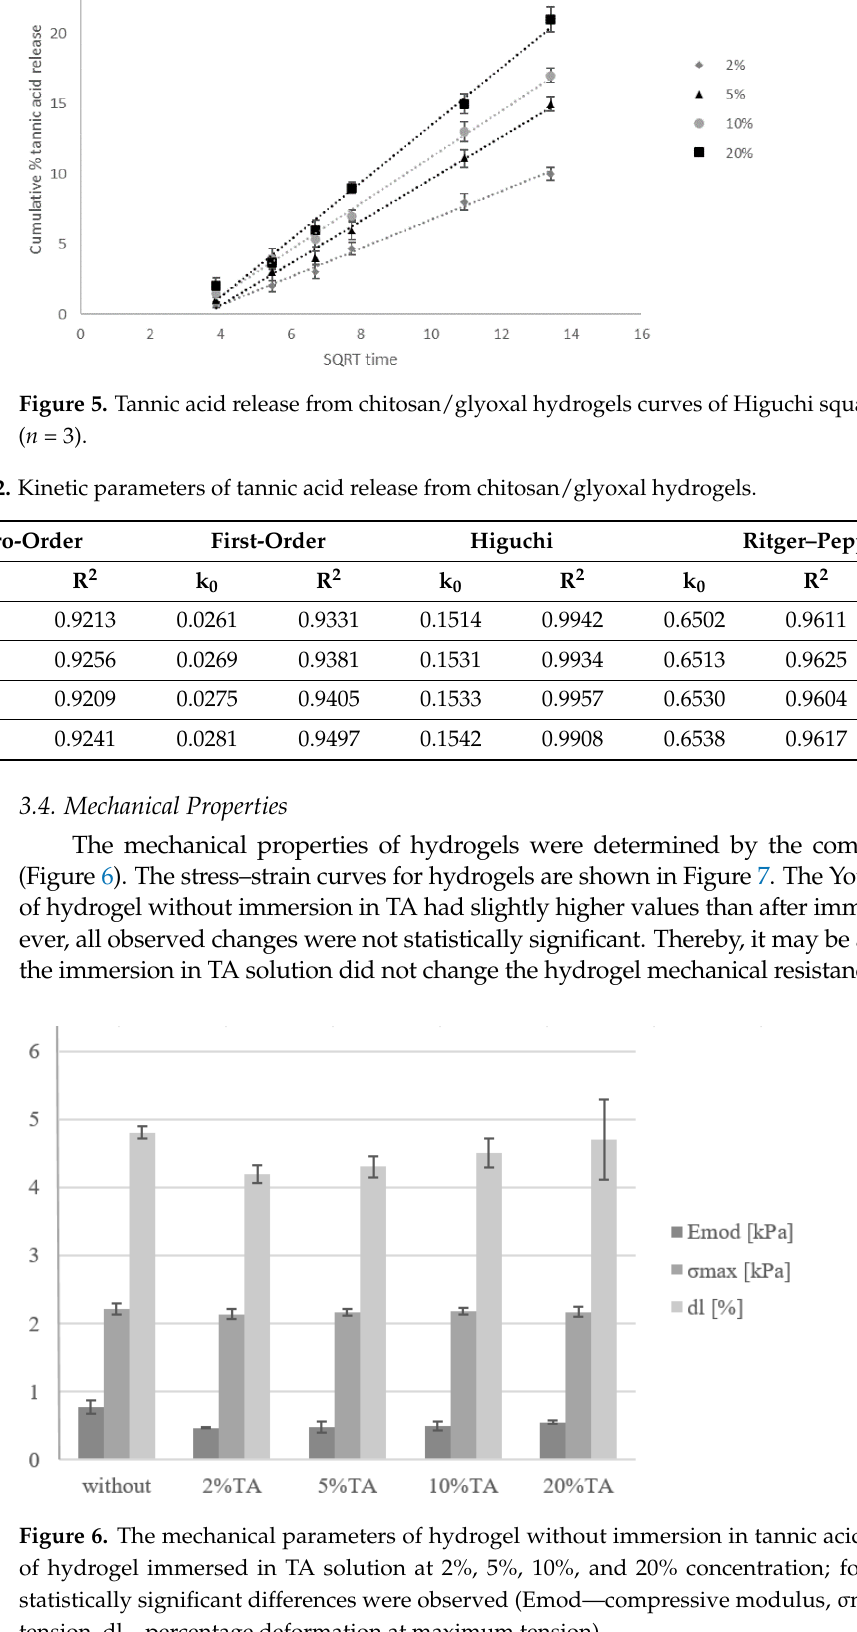
Figure 7. Stress – strain curves for hydrogel without immersion in tannic acid solution and of hy- drogel immersed in TA solution at 2%, 5%, 10%, and 20% concentration. 3.5. Swelling Properties Hydrogels are materials with a high ability to swell. Hydrogels without immersion in TA solution showed high percentage swelling (Figure 8). Materials firstly immersed in TA solution had already swelled. Thereby, we did not observe a significant increase in the hydrogel weight. After 7 h of immersion in PBS, we observed a decrease in hydrogel weight, which may suggest that the dissolution process occurred.